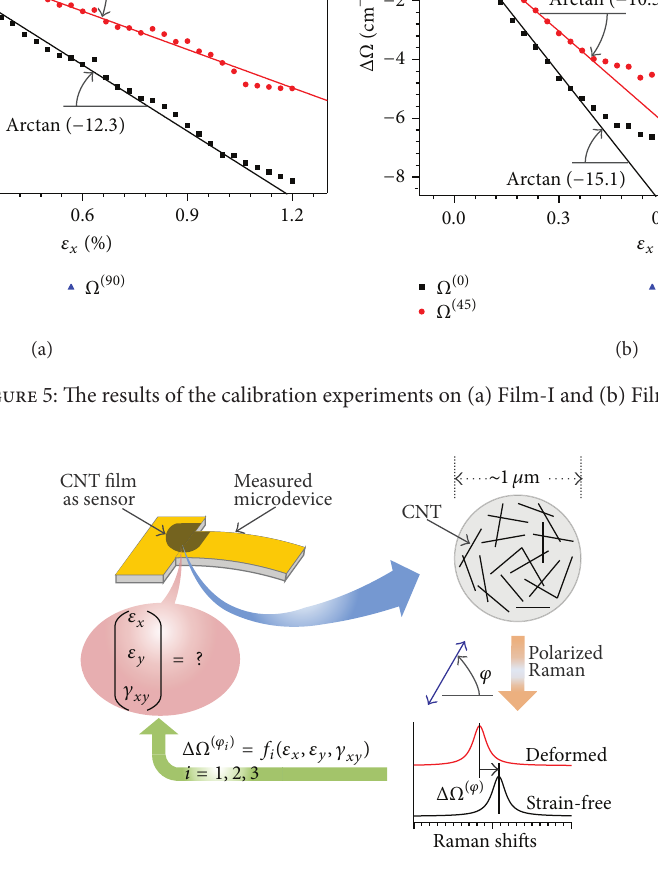
Figure 6: The standard procedure of strain measurements using the CNT strain